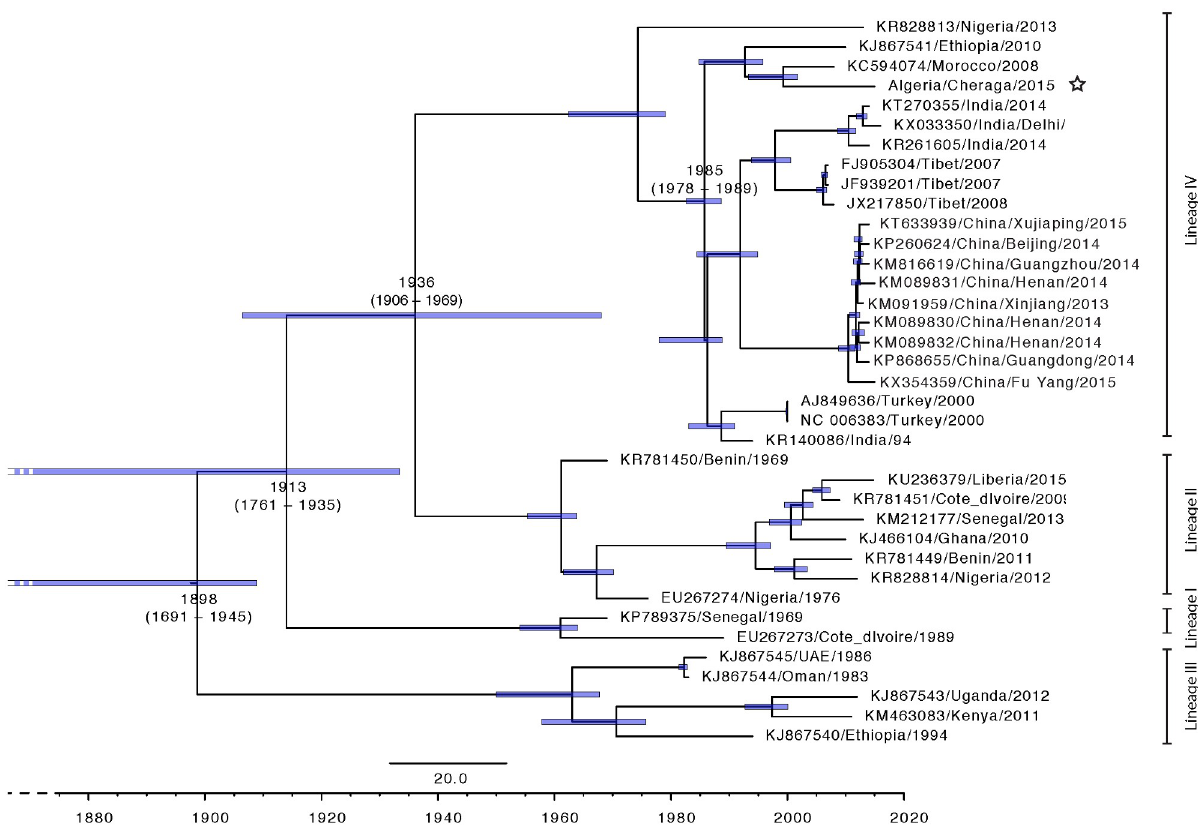
Fig 5. Time-scaled BayesianMCC phylogeny tree based on peste des petits ruminants virus complete genome sequences (n = 38). The Algeria/Cheraga/2015sequenceis indicatedby a white star. The tree was constructed using the uncorrelated exponential distributionmodel and exponential tree prior. Branch tips locationscorrespond to year of collectionand tip labelsindicate accession number, as well as locationand year of collectionand branch lengthsreflect elapsedtime. Tree nodes were annotatedwith the estimated median time to most recent common ancestor (TMRCA). Corresponding 95% highestposterior density (HPD) values of TMRCA are indicatedas blue bars. Horizontalaxis indicatestime in years and for presentation truncated to 1860.